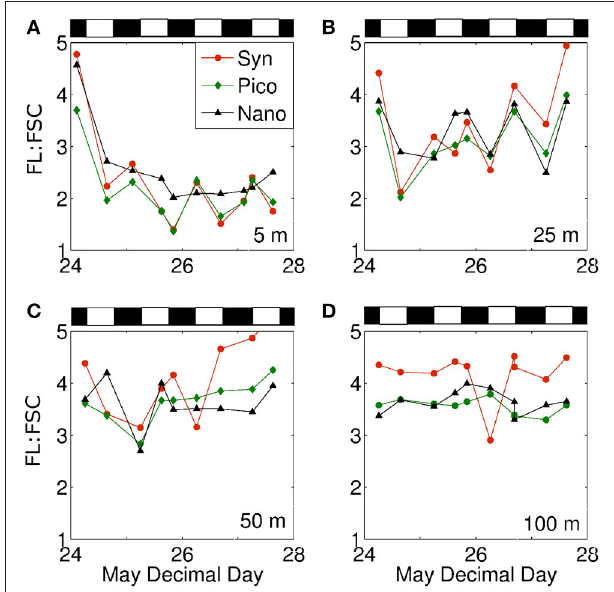
FIGURE 6 | Mean cell fluorescence to forward scatter ratio at (A) 5m, (B) 25m, (C) 50m, and (D) 100m for Synechococcus (red), picophytoplankton (green), and nanophytoplankton (black) plotted against time. Black and white bars above plots represent night and day, respectively.